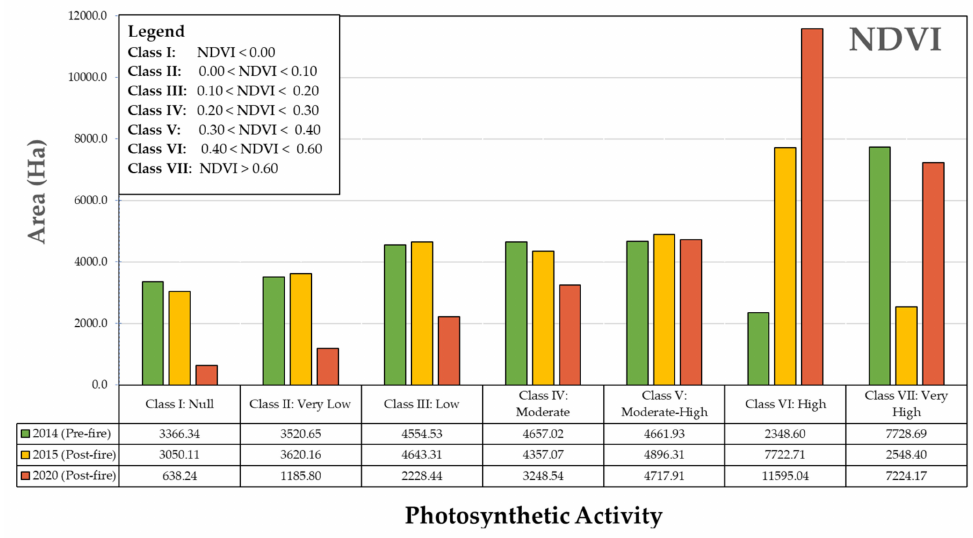
Figure 6. Photosynthetic activity according to the pre- and post-fire NDVI indices, calculated with Landsat-8